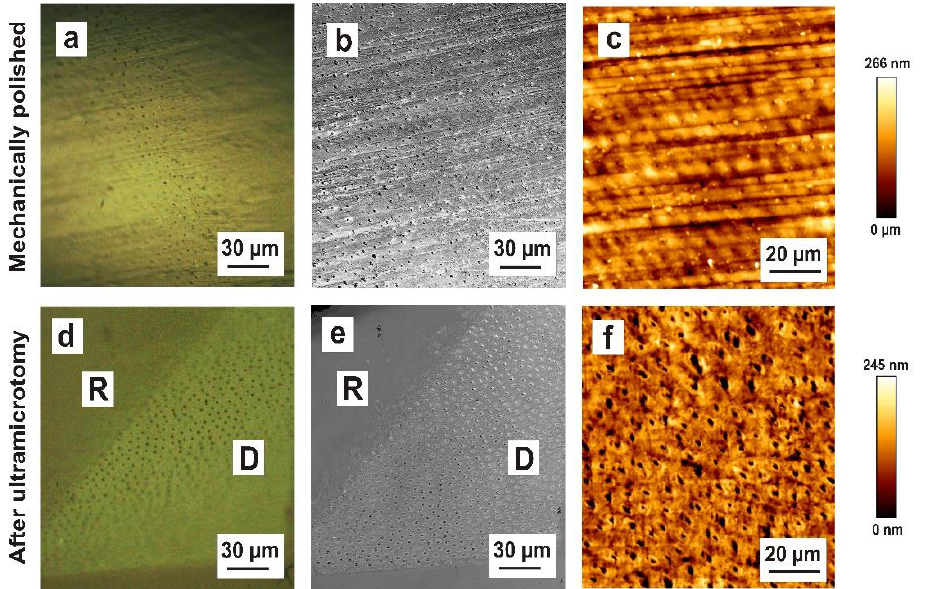
Figure 6. Comparison of dentine block surface morphology after mechanical polishing and ultramicrotomy. ( a ) Reflected-light microscopy (differential interference contrast mode) of mechanically polished dentine showing polishing marks on the dentine surface. ( b ) Confocal laser scanning microscopy of mechanically polished dentine showing scratches and polishing marks. The microstructure of dentine (dentinal tubules and intertubular substance) is obvious. ( c ) AFM micrograph of mechanically polished dentine depicting scratches and polishing marks. ( d ) Reflected-light microscopy of the dentine block surface after ultramicrotomy, showing the microstructure of dentine (dentinal tubules and intertubular substance) with dentine (D) and resin (R). ( e ) Confocal laser scanning microscopy of the dentine surface after ultramicrotome preparation depicting numerous dentinal tubules and the intertubular substance with dentine (D) and resin (R). ( f ) AFM micrograph of the dentine surface after ultramicrotome preparation showing numerous dentinal tubules and the intertubular